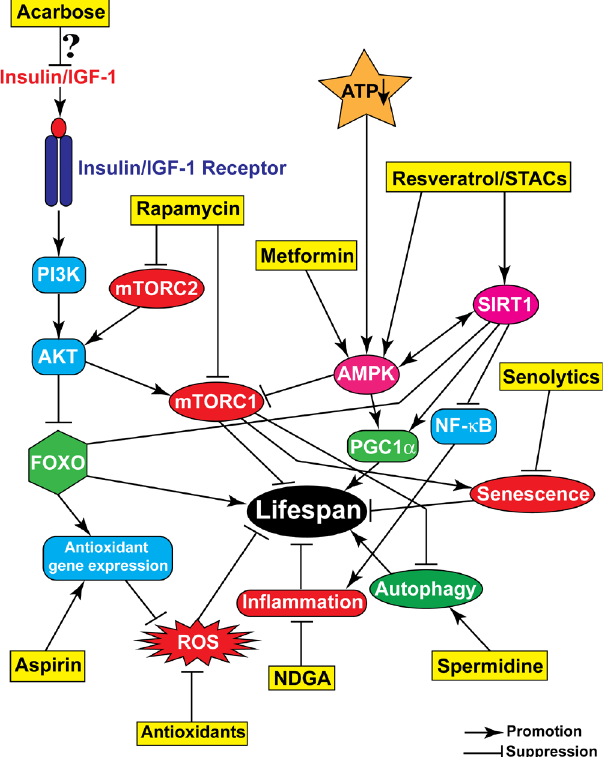
Figure 2. Pharmacological interventions targeting aging-related pathways and processes. Representative compounds (yellow boxes) target various processes or pathways that contribute to aging and either promote or suppress their activities/progression, resulting in improved health and enhanced